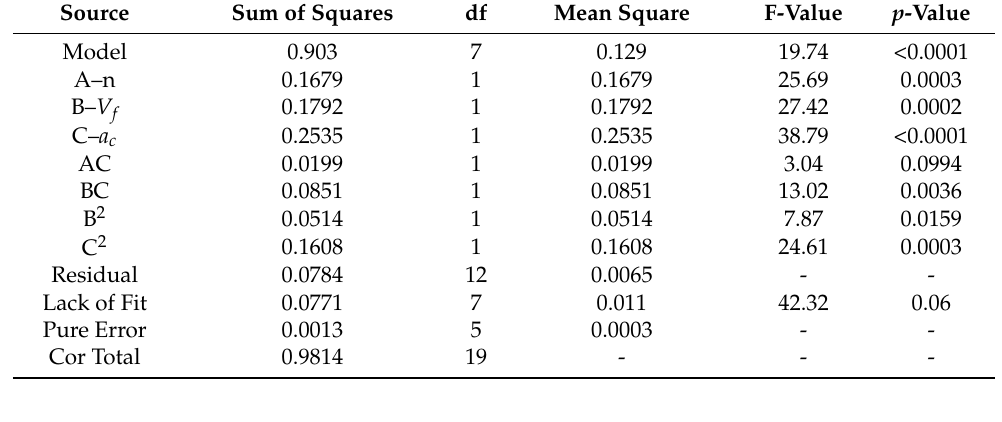
13 of 18 3.3. Effect of Milling Parameters on the Average Chip Size L a Upon analysis of the experimental data, it can be observed that the regression of the model is extremely significant with a p ‐ value of less than 0.0001. The regression process of three individual factors, spindle speed n , feed rate V f , and depth of cut a c , revealed that all three contributed significantly to the average chip size La ( p ‐ values less than 0.0004 for each factor). The analysis of variance for the regression model is presented in Table 6, and the regression polynomial for La can be found in Equation (28). A visualization of the mean chip size L a is displayed in Figure 8. 5 (28) Table 6. The model’s R 2 value, adjusted R 2 value, and predicted R 2 value were determined to be